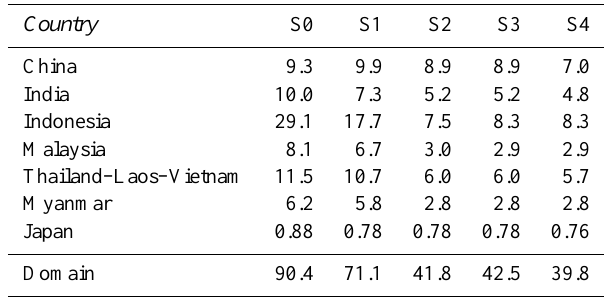
Fig. 5. Annual percentage trend in isoprene emissions derived from the S0 simulation (a) , decadal temperature trend (b) , annual percentage PAR trend (c) and annual percentage trend in the soil moisture activity factor (d) over 1979–2012 based on ERA-Interim data. Table 2. Annual isoprene emission estimates per country simulated in the five scenarios of Table 1 for 2005. Units are Tg of isoprene. The domain extends from 9.75 ◦ S to 54.75 ◦ N and from 60.25 ◦ E to 149.75 ◦